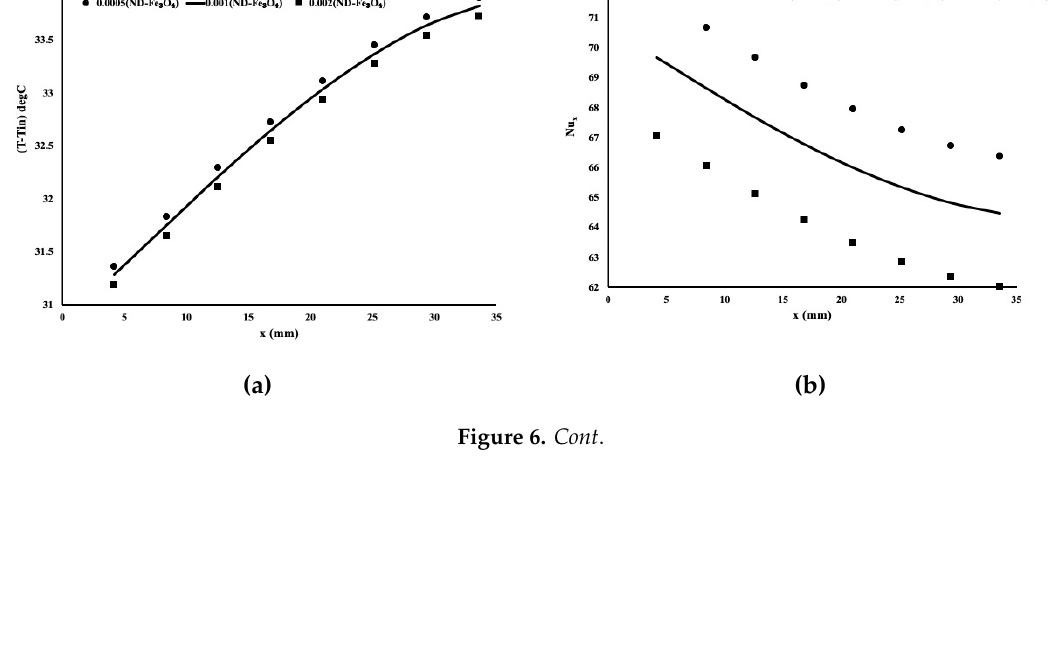
Figure 5. Heat enhancement using the MWCNT– Fe 3 O 4 in water mixture. ( a ) Temperature variation along the flow, ( b ) Nusselt number of each individual mixture, ( c ) Nusselt number using standard definition.